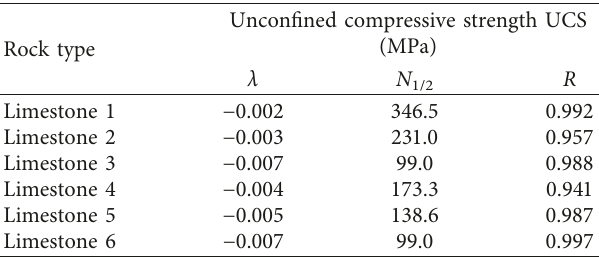
1/2 ), and coefficient of